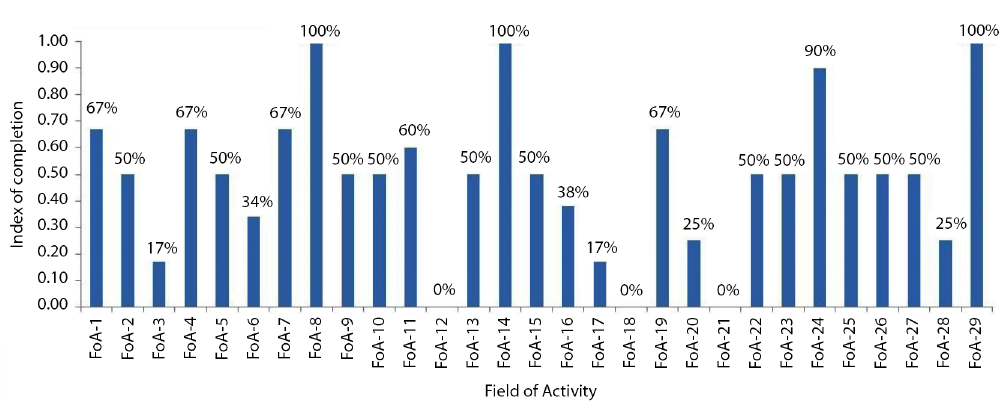
Figure 9. Detailed assessment of each field of activity in the life-cycle of